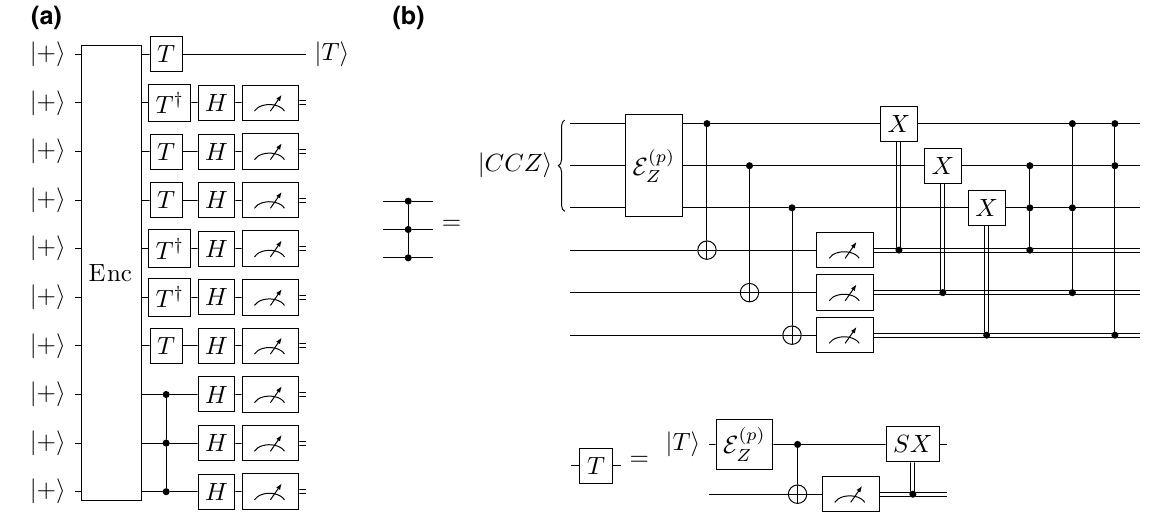
FIG. 2. (a) The [[10,1,2]] MSD protocol, consisting of the encoding circuit, noisy application of the logical T gate, and measurement. The protocol is successful if the measurements give a trivial error syndrome. The labeling of the qubits is the same as in Fig. 1(d). (b) The state injection circuits for implementing T and CCZ gates using input magic states. We assume that all components of the circuit are ideal except for the preparation of the magic states, which we model as ideal preparation followed by the noise channels implicit in Eqs. (3) and (4).